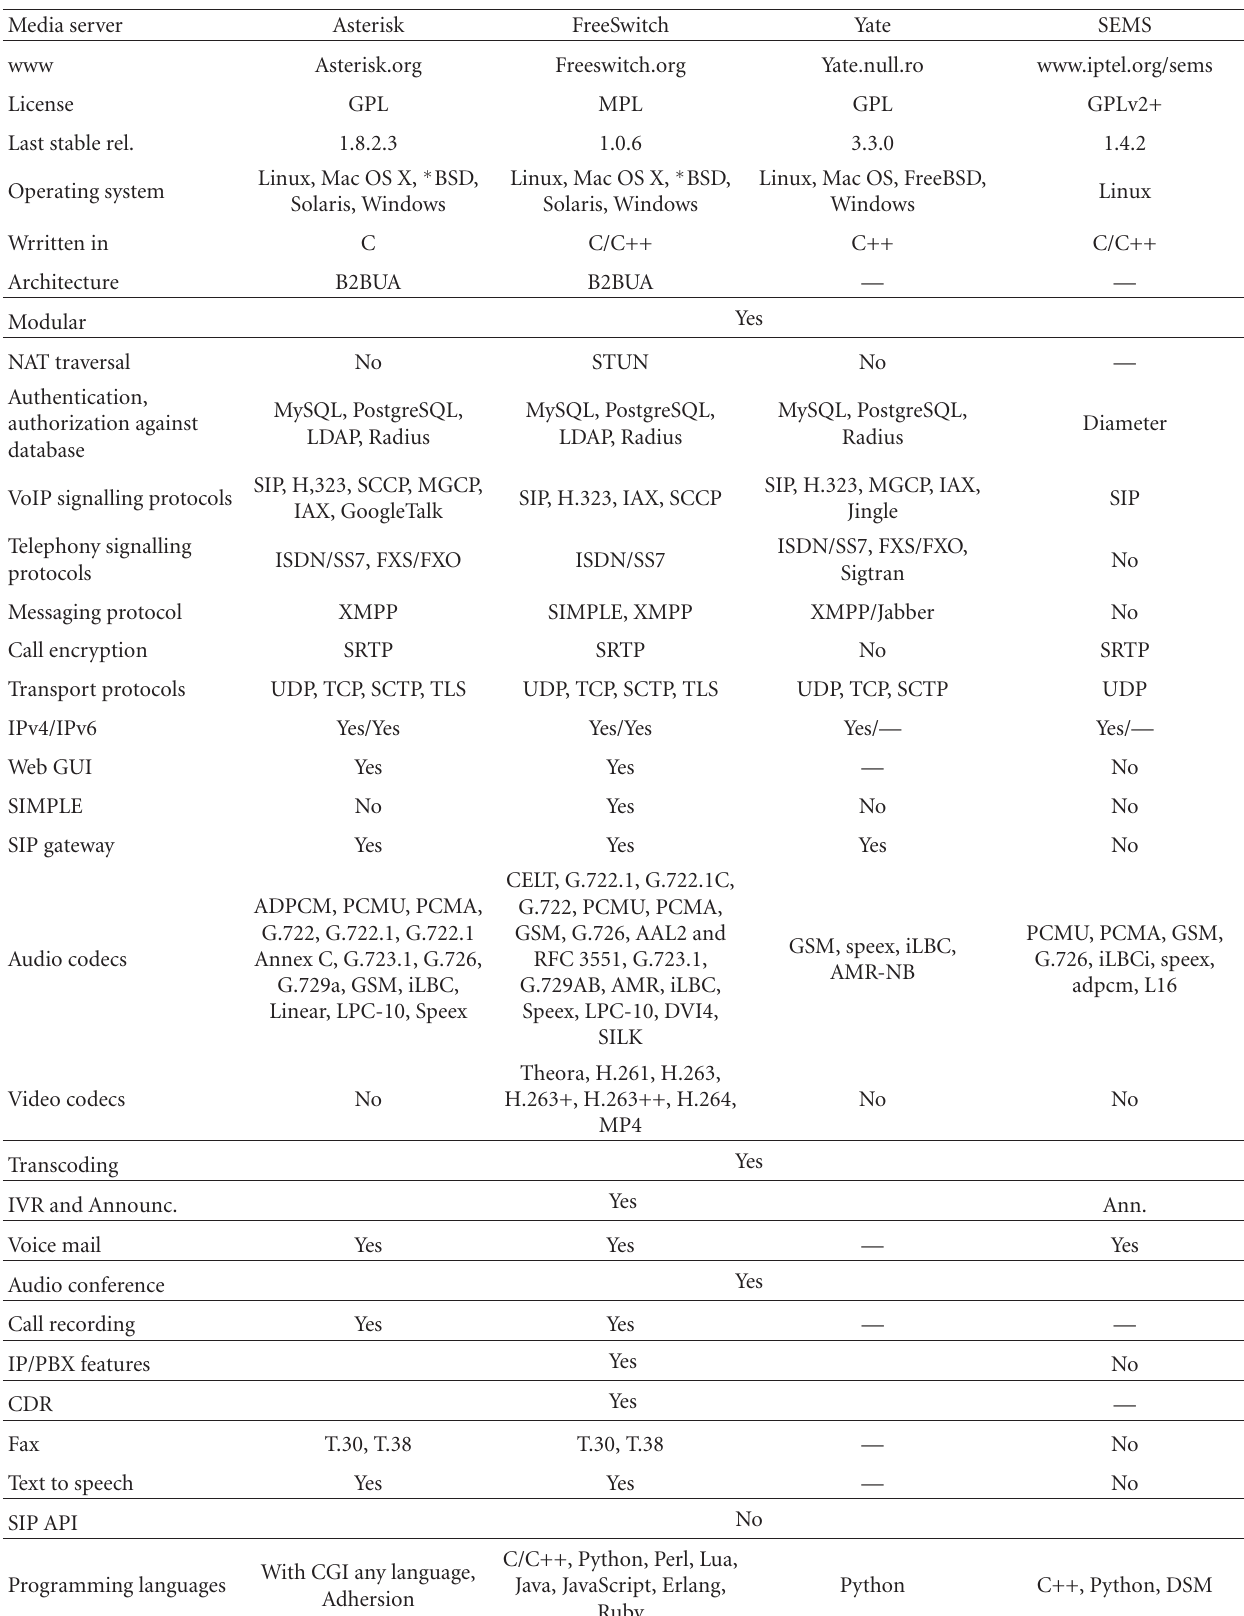
Table 3: Media server